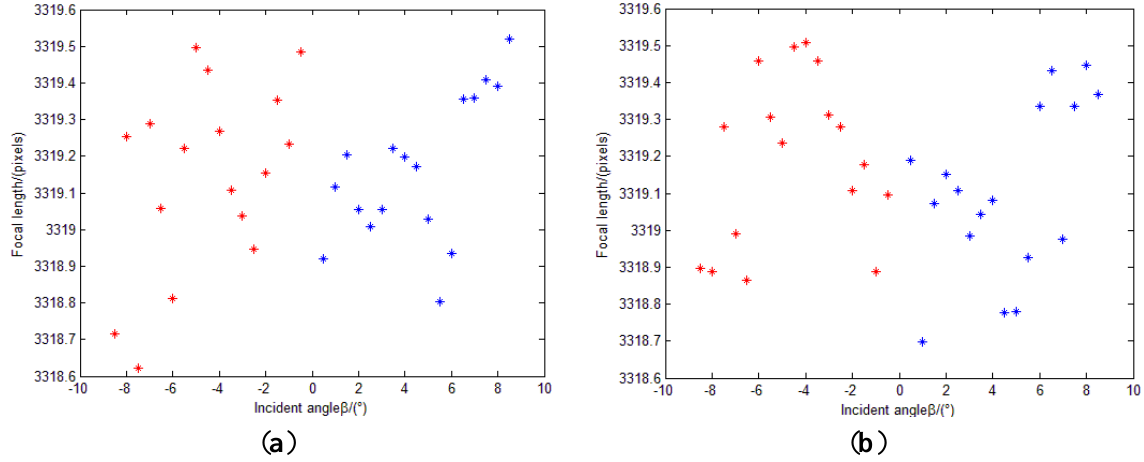
Figure 24. Re-estimations of f . ( a ) is the result of 1st measurement direction L and ( b ) is the result of 2nd measurement direction L centrosymmetry incident light rays